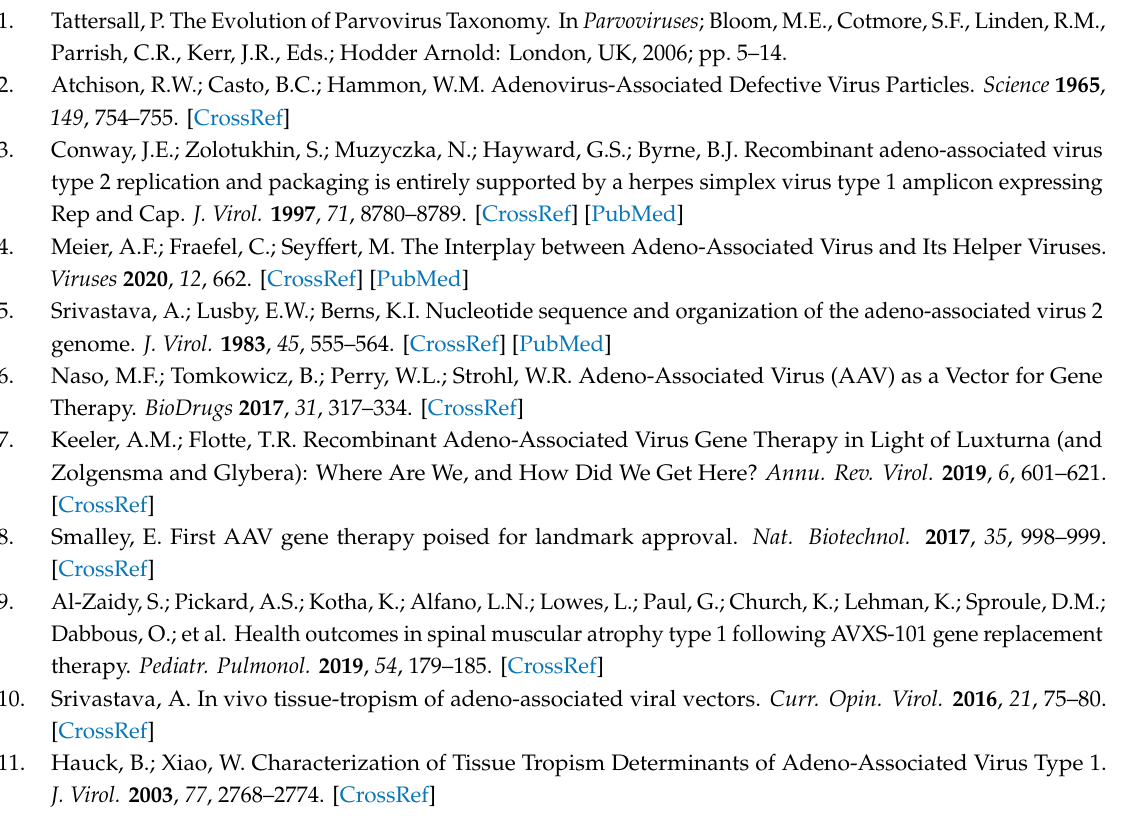
Figure S1: Fourier Shell correlation (FSC) curves from the Relion program Postprocess, Figure S2: Coulombic potential maps representing local resolution, Figure S3: The 10 Å lowpass filtered cryo-EM coulombic potential map for AAV5 in complex with PKD1-2, Figure S4: Typical Micrographs from the datasets, Figure S5: A full sized roadmap of PKD1 footprints on